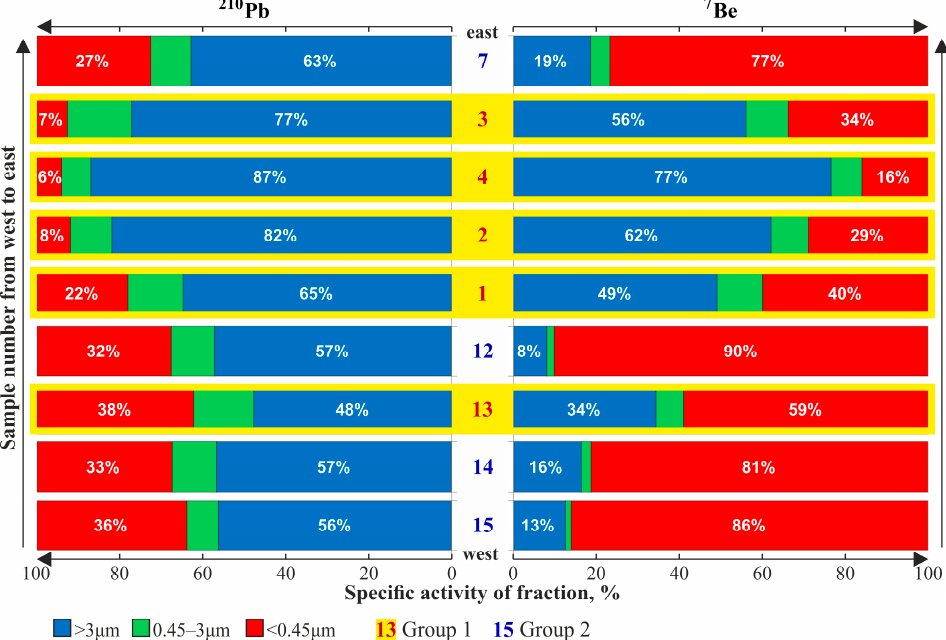
Figure 9. The contribution of particulate fractions (%) of suspended matter in snow water to the total activity of 210 Pb atm and 7 Be, sampled from west to east in the territory of Yamal-Nenets Autonomous District (YNAD).